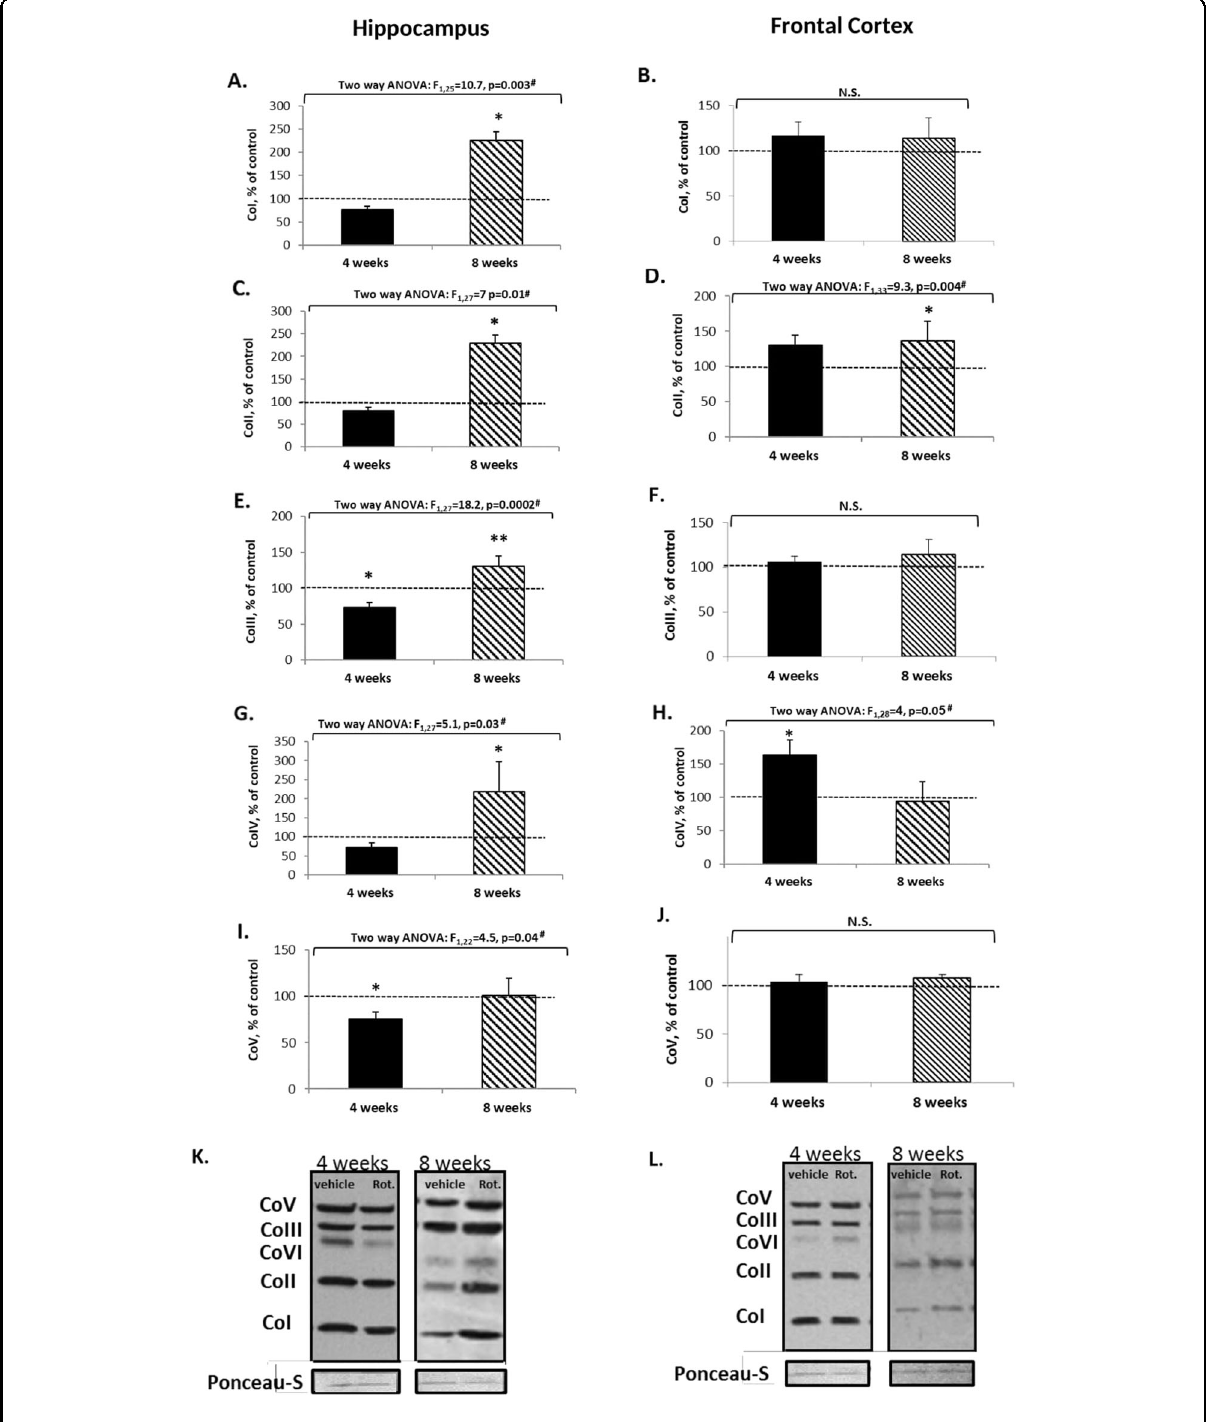
Fig. 5 (See legend on next